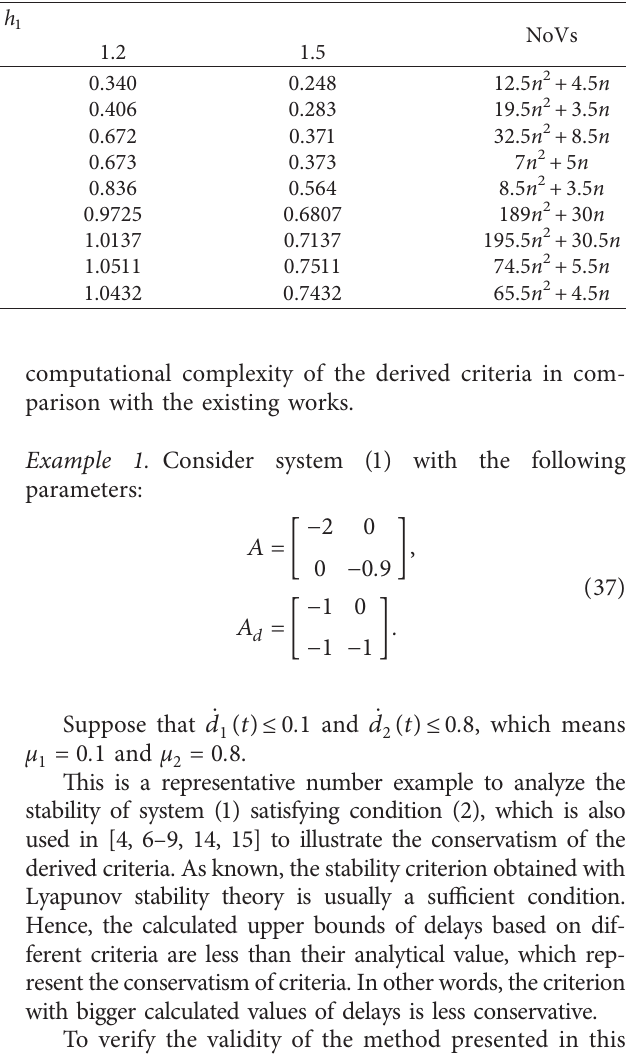
Table 1: The calculated upper bounds of d